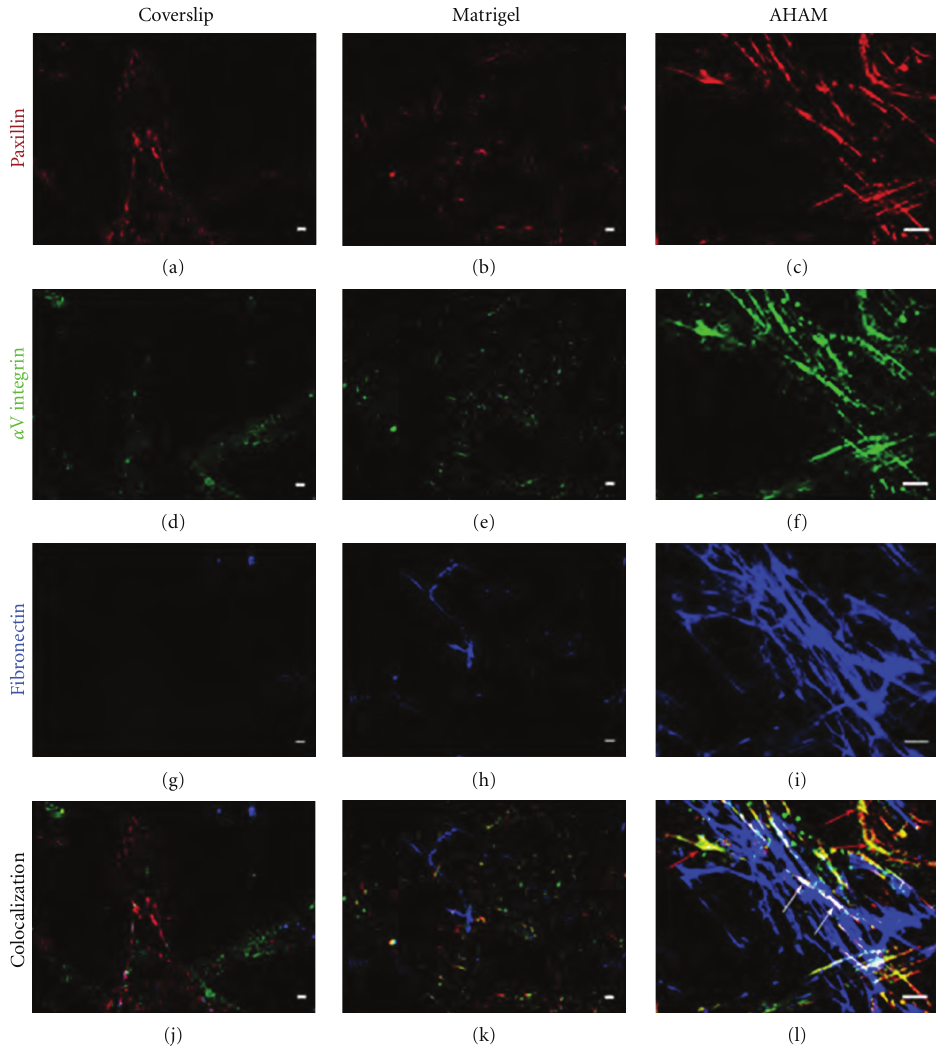
Figure 5: Confocal images of indirect immunofluorescence staining of HFFs on the AHAM, glass coverslips, and Matrigel. Triple labeling of α V integrin (green) ((a)–(c)), paxillin (red) ((d)–(f)), and fibronectin (blue) ((g)–(i)) was performed. Colocalization was observed as white bands (white arrows) only within the AHAM (l), and not with cell adhesions on coverslips (j) or Matrigel (k). Colocalization of α V integrin and paxillin was detected as yellow bands (red arrows) in regions without fibronectin only within the AHAM (l). Scale bar, 10 μ m.